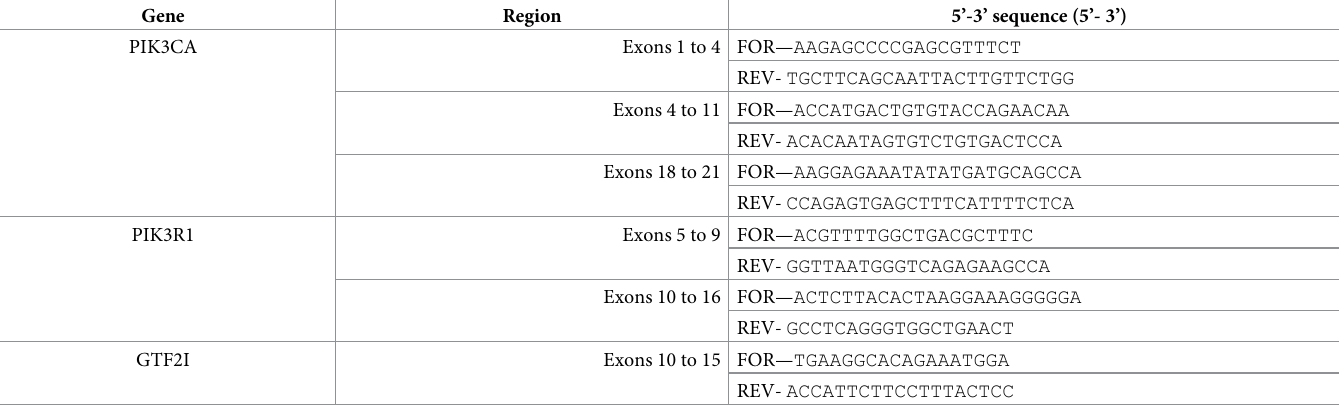
Table 2. Primers used to amplify GTF2i and PIK3 genes.